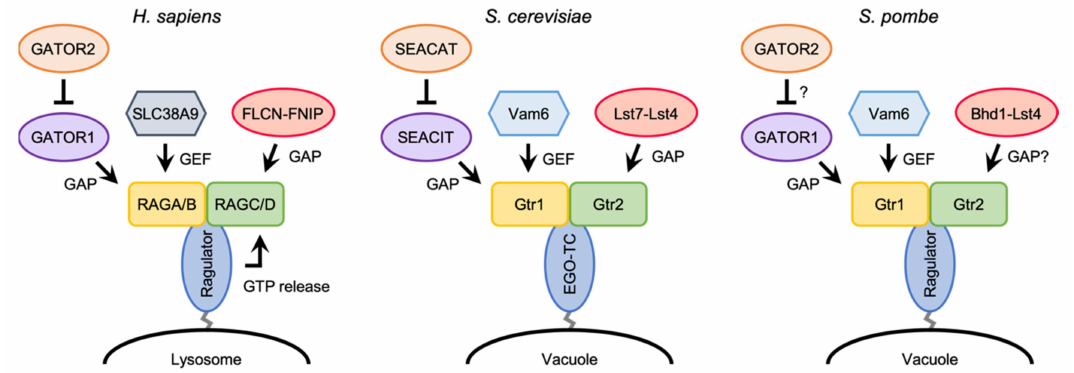
Figure 3. Regulations of the nucleotide-binding state of the RAG/Gtr heterodimer in mammals, budding yeast, and fission yeast. Functions of the fission yeast GATOR2 and Bhd1-Lst4 complexes are yet to be